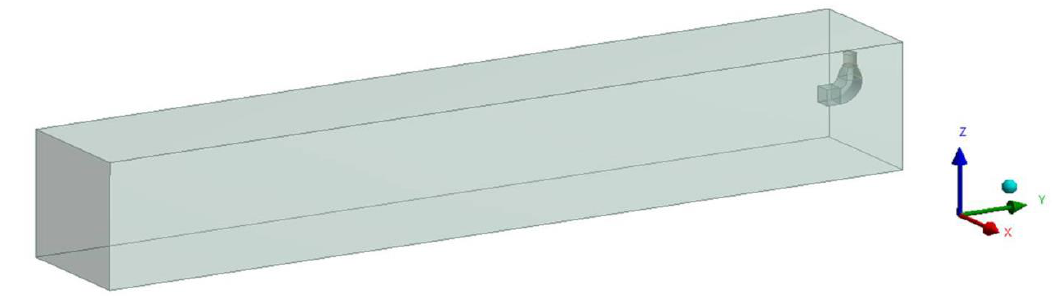
Figure 1. Geometric model and calculation field for the square exhaust hood.